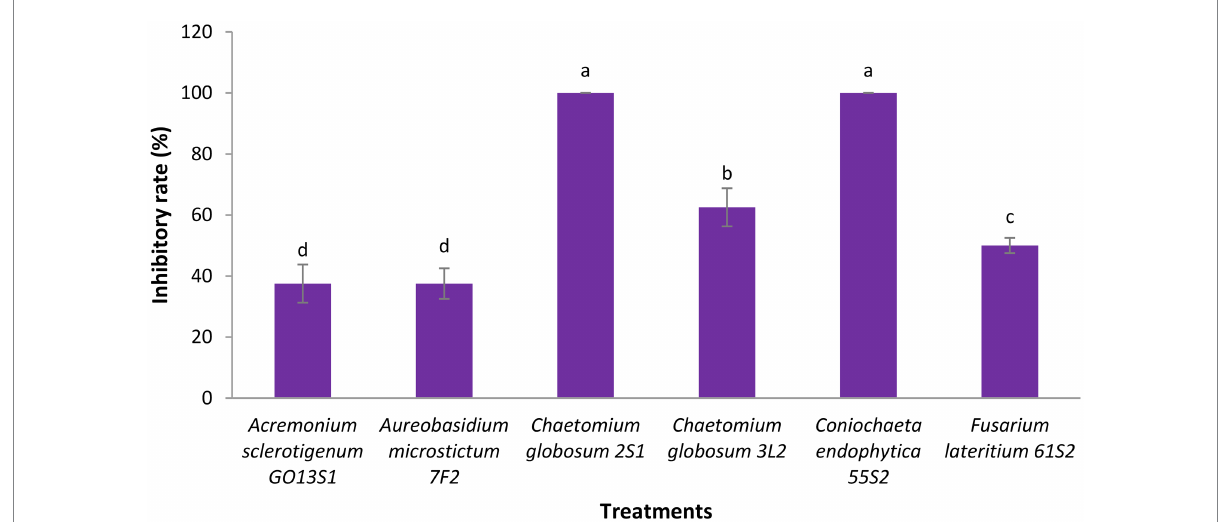
FIGURE 11 Antagonistic effect of endophytic fungi isolated from apple against apple scab disease on apple seedling after 1 month of pathogen inoculation under greenhouse conditions. Data are the means ± SE of three replicates. Values of histograms with common letters are not significantly different at p ≤ 0.01 according to Duncan’s multiple range test.